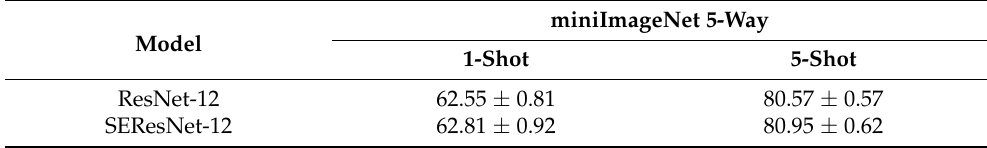
Table 8. Meta-learning accuracy of different backbones on miniImageNet.